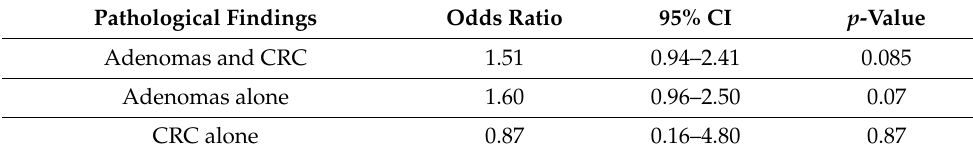
Table 2. Univariate analysis of colonoscopic findings association with